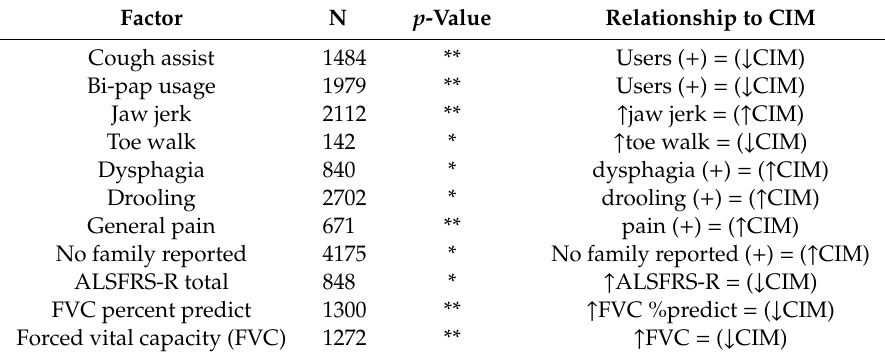
Table 3. Factors with a significant association with clinical impression of mood